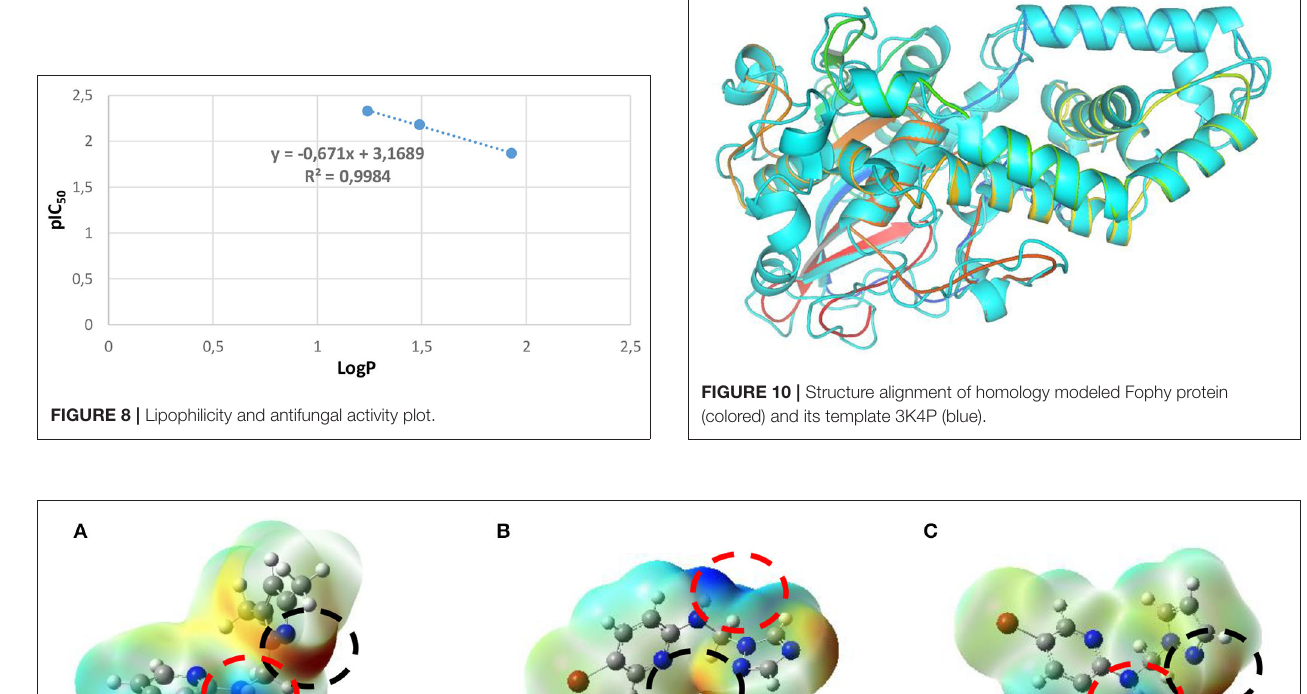
Frontiers in Chemistry |